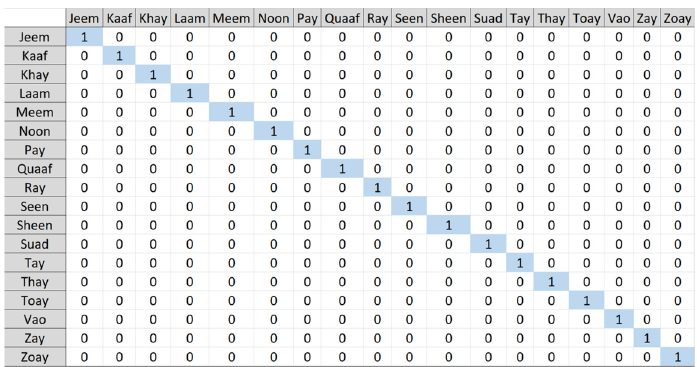
Figure 24. Confusion matrix of letters within PSL dataset (set 1).